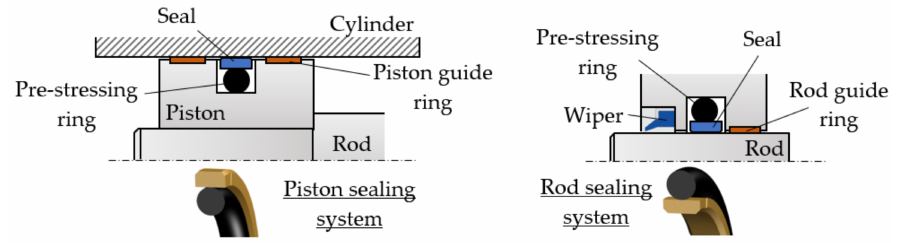
Figure 1. Coaxial sealing